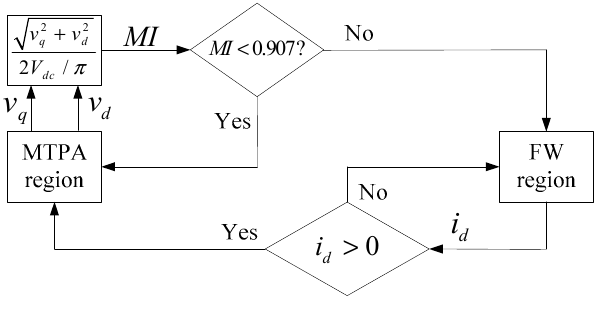
Figure 3. The transition between the constant torque and the flux-weakening regions.